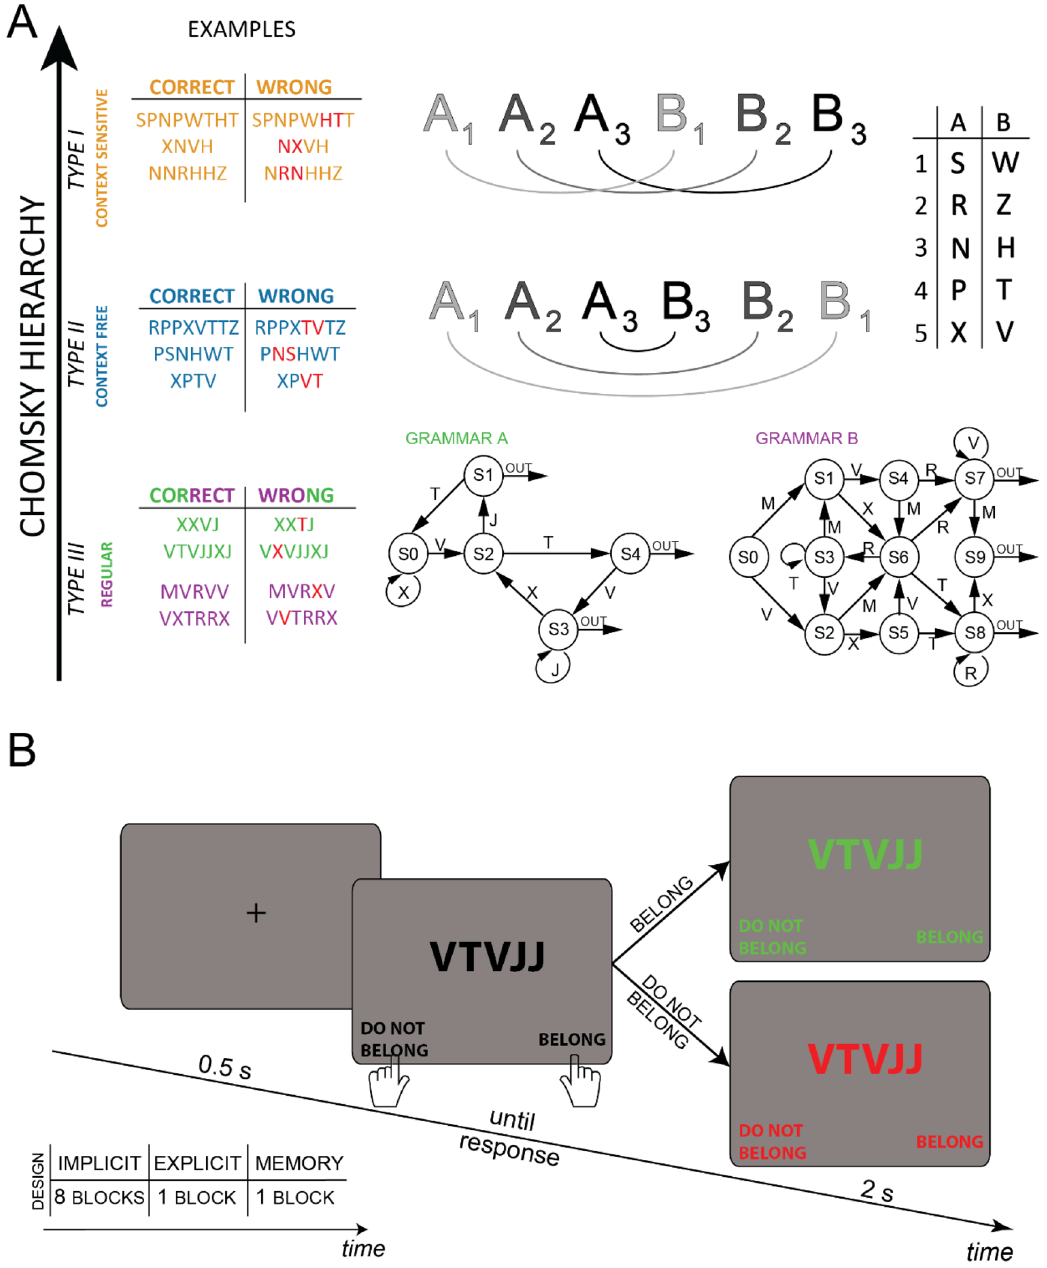
Figure 1. ( A ) A schematic representation of the 4 grammars employed in this study, arranged according to the Chomsky hierarchy. Type I or Context Sensitive grammar (CS, in orange), a translation was applied from the first to the corresponding second half of the string. For example, considering the first half as ‘PPN’ and referring to the same pairing as in the picture, the corresponding mirrored version would be ‘HTT’ in the CF, and ‘TTH’ in the CS grammar. The incorrect sequences were obtained by switching only two non-identical letters within one of the two halves (in red in the table). In type II or Context Free grammar (CF, in blue), the second half of the sequence mirrored the first half, applying the respective pairing to each letter (e.g. if A3 was the letter N, then the letter B3 was H). Note that a correct string in the context free grammar is considered as incorrect in the context sensitive, and vice versa. Regular grammars are defined by a scheme organized in directionally connected nodes (type III, the lowest in green and purple). For both grammars A and B, each correct sequence was generated starting at node S0 of each respective scheme, and then randomly choosing an arc departing from that node and recording its letter. This procedure was iterated until one of the arc labeled as ‘out’ was reached, thus terminating the string. Incorrect sequences had only one inexact item, being substituted by another letter from the proper vocabulary but violating grammatical rules (in red in the table). ( B ) Time-course of each trial. All the human experiments employed the same design. The sub-table reports the number of blocks for each session: implicit, explicit and memory. See “Experimental design” section for